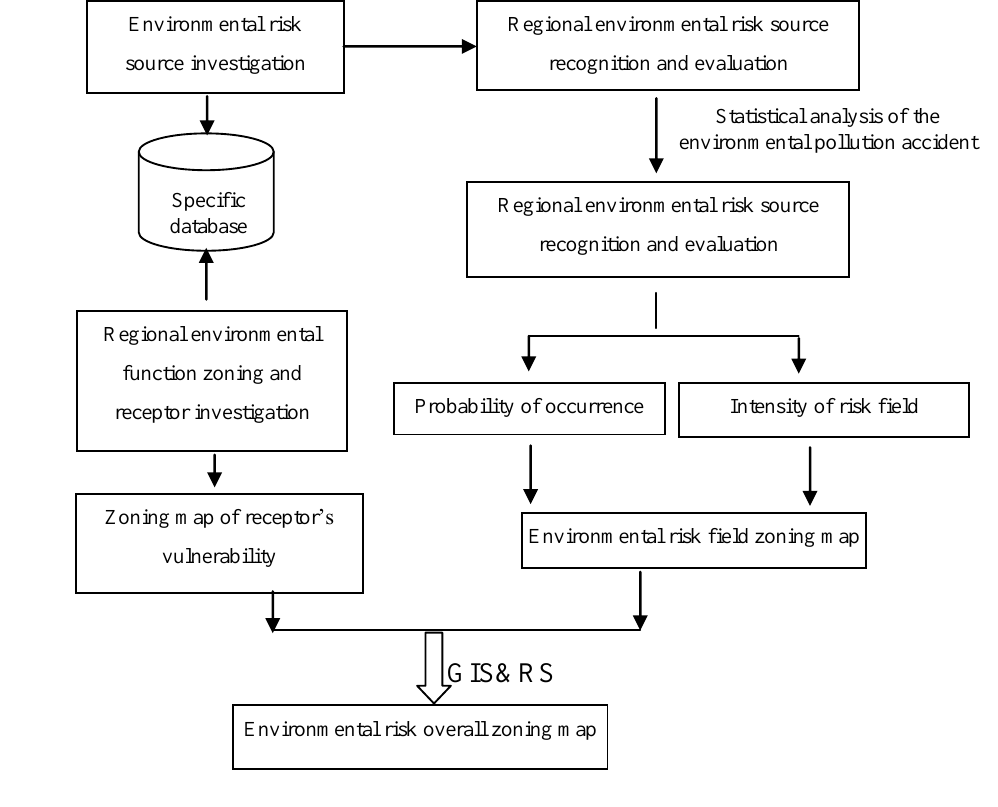
Figure 4. Process flow of environmental risk assessment and zoning in chemical industrial parks.